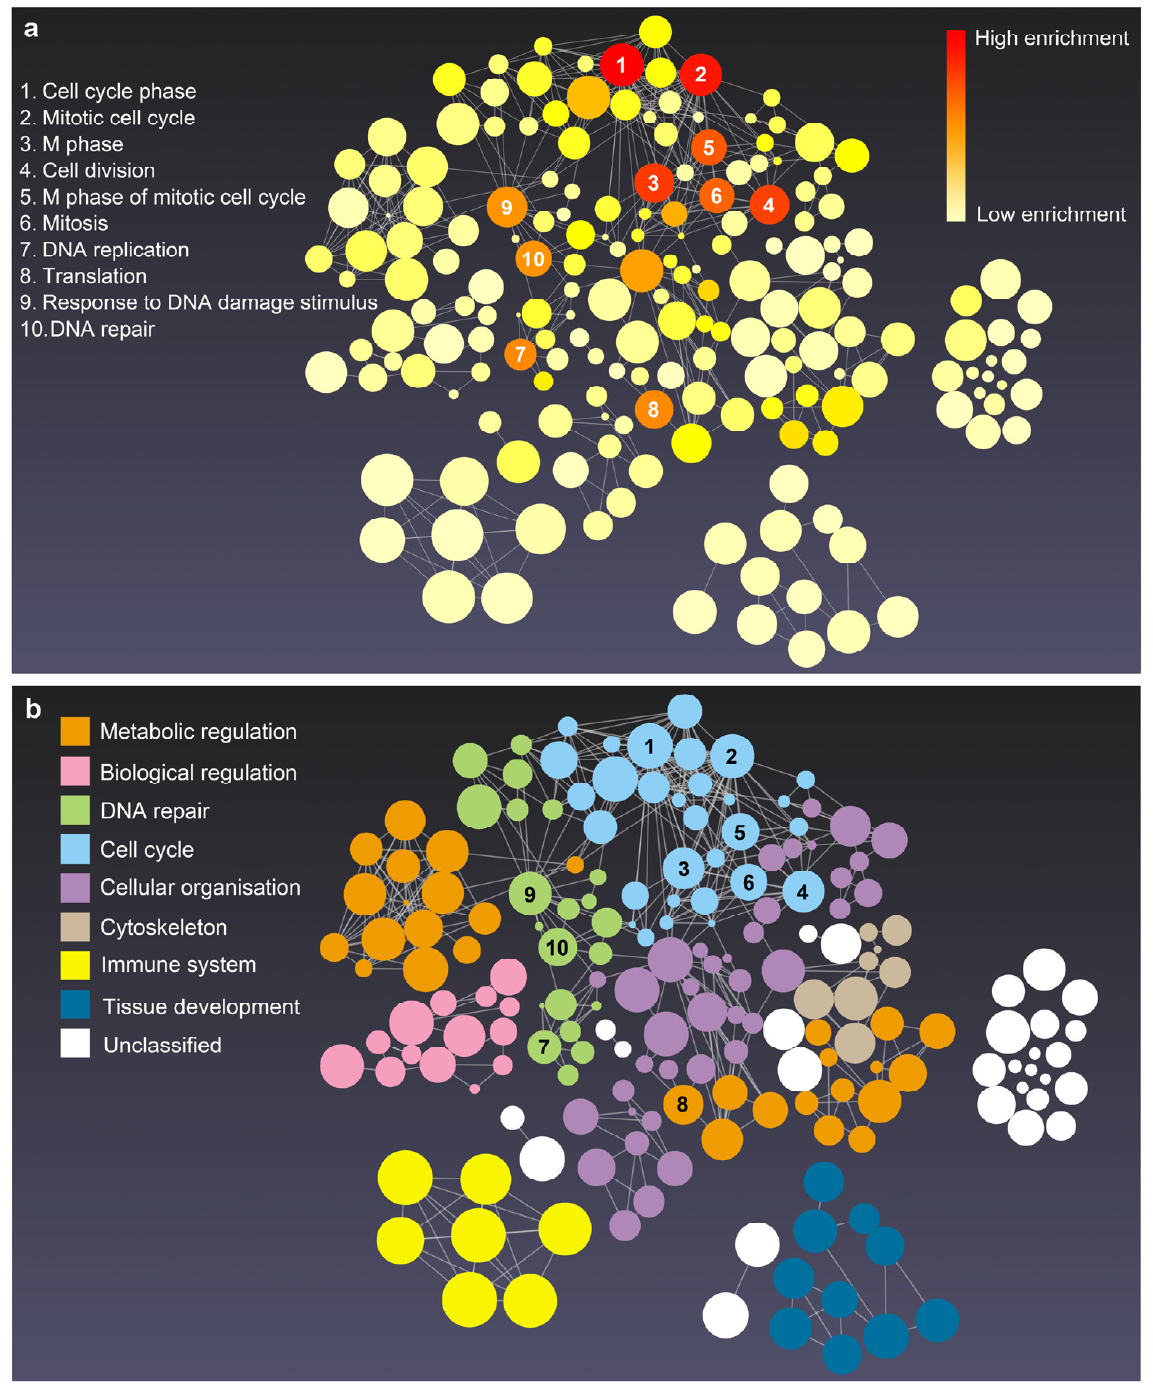
Figure 4. The enrichment network of biological process of phoenix spheres. Created in the enrichment visualisation tool on the NetworkAnalyst platform. Bubble size is associated to the size of gene sets. ( a ) Enrichment network with red to light yellow colours based on the adjusted p -value. Red represents the lowest p -value while light yellow stands for the highest p -value; ( b ) the identical network as ( a ) but coloured according to the categories of GO terms. Each colour belongs to one category of terms. The spatial distance between different categories indicates similarity. The closer the more similar in biological process. The numbers 1 to 10 on ( a , b ) represent the top 10 enriched